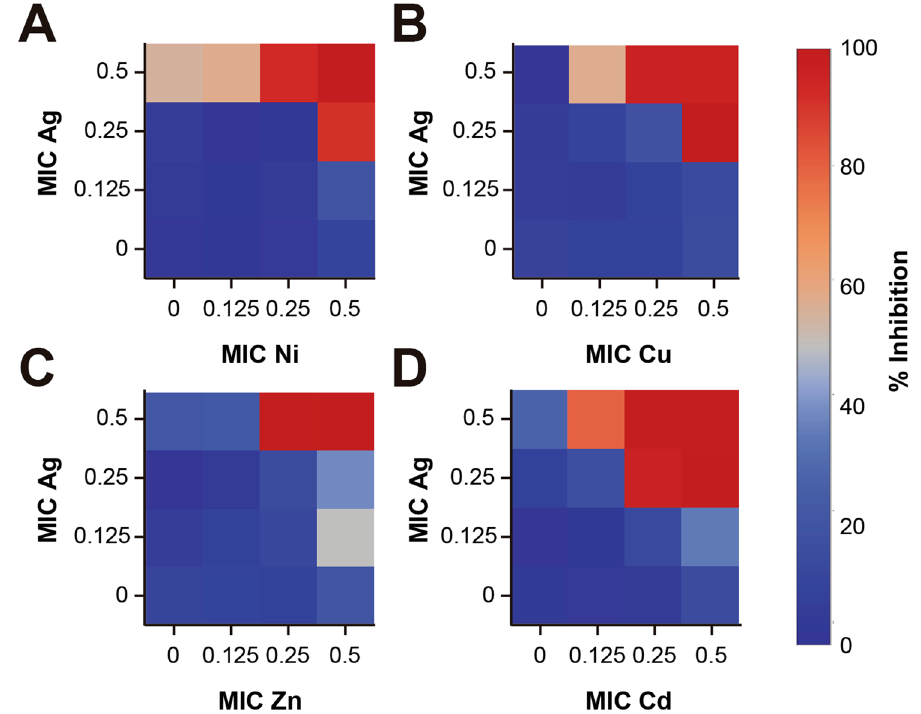
Figure 1. Inhibitory Effect of the MIC dilutions of Ag potentiated by transition metals against E. coli . Inhibitory percentage by sub-inhibitory combinations of Ag-transition metals in Escherichia coli ATCC 11229. Experiments with combinatorial treatments of Ag with ( A ) Ni, ( B ) Cu, ( C ) Zn and ( D ) Cd. Each combinatorial treatment with inhibition > 80% is significantly different to the effects of the individual treatments. Each checkerboard treatment was performed in